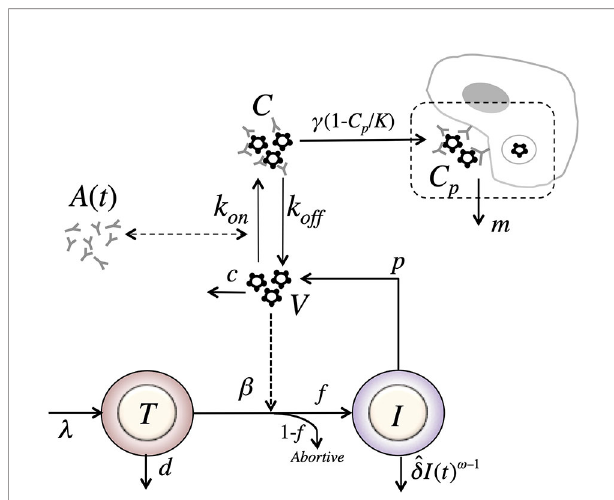
FIGURE 8 | Schematic of the phagocytosis-basedlogistic clearance model (for one virus population) used to analyze the virus dynamics after VRC01 infusion. The model includes fi ve variables: target cells ( T ), productively infected cells( I ), free virus ( V ), VRC01-HIV immune complexes ( C ), and complexes cleared by phagocytes ( C ). Parameters l , d and b s are the production, death and infection rates of target cells; d is the death rate of infected cells; p and c are the production and clearance rates of free virus; k on and k off are the binding and dissociation rate constants of VRC01 to free virus; g , K and m are the phagocytosis mediated maximum clearance rate, carrying capacity and degradation rate of VRC01-HIV immune complexes. The antibody concentration, A ( t ), is determined from the best- fi ts of the two-compartmental model to VRC01 concentration measurements for each individual (see